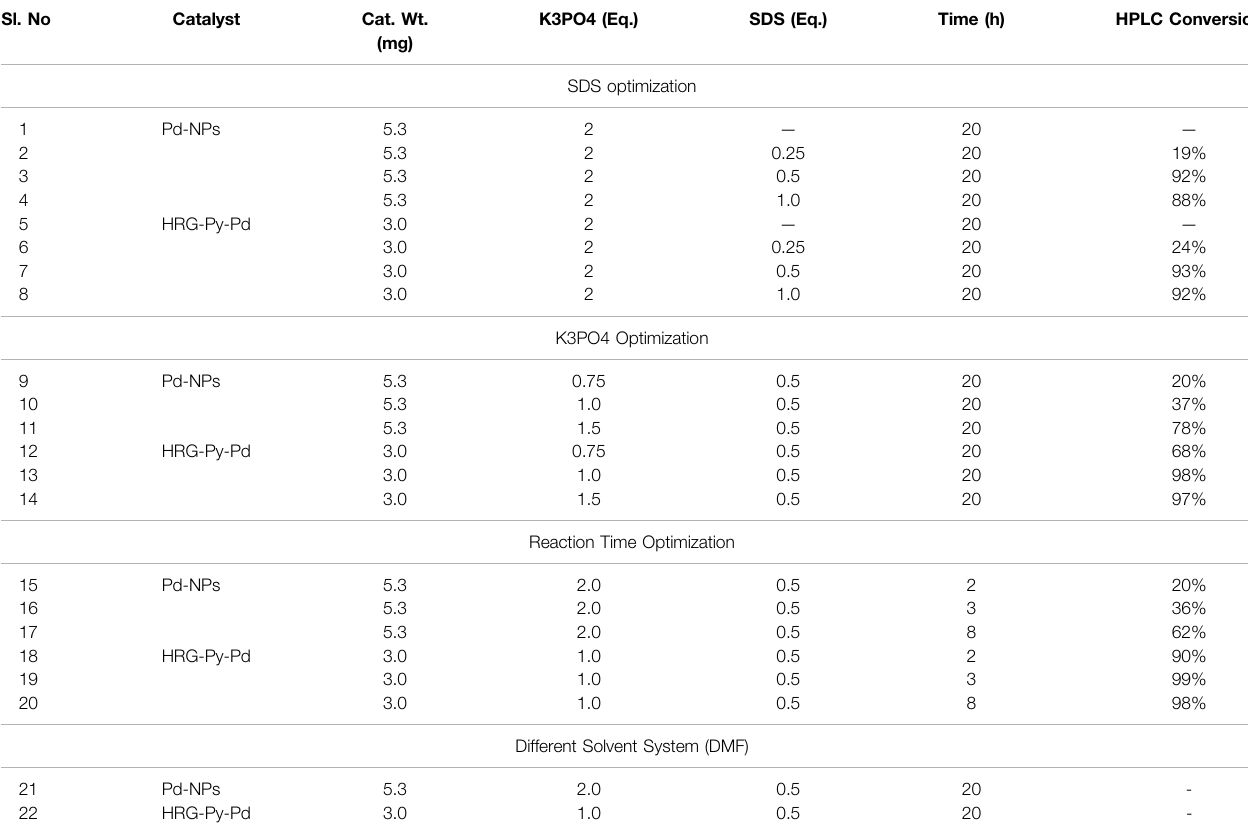
TABLE 2 | Mizoroki-Heck reaction of 4-bromoanisol (1a) and acrylic acid (2) in aqueous solution using best catalyst HRG-Py-Pd; Optimization for K3PO4, SDS, and reaction time. Sl.